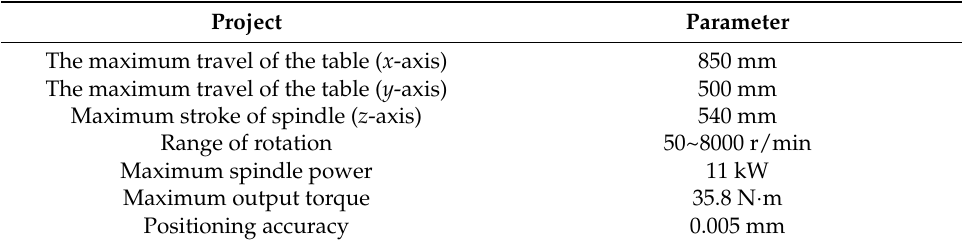
Figure 4. Test platform of TC4 titanium alloy in LTUAG. Table 1. The parameters of VMC850E machining center